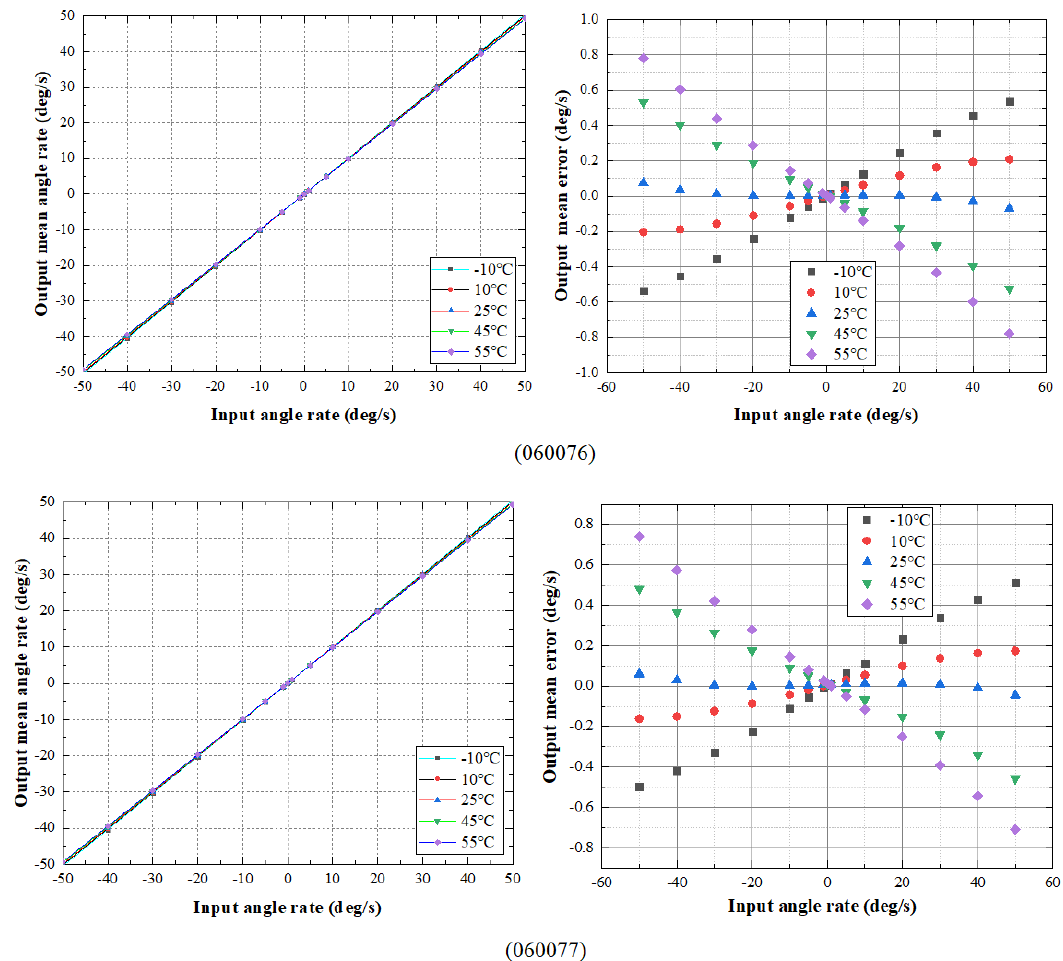
Figure 4. Input angular rate of the turntable vs. output of the gyroscopes.